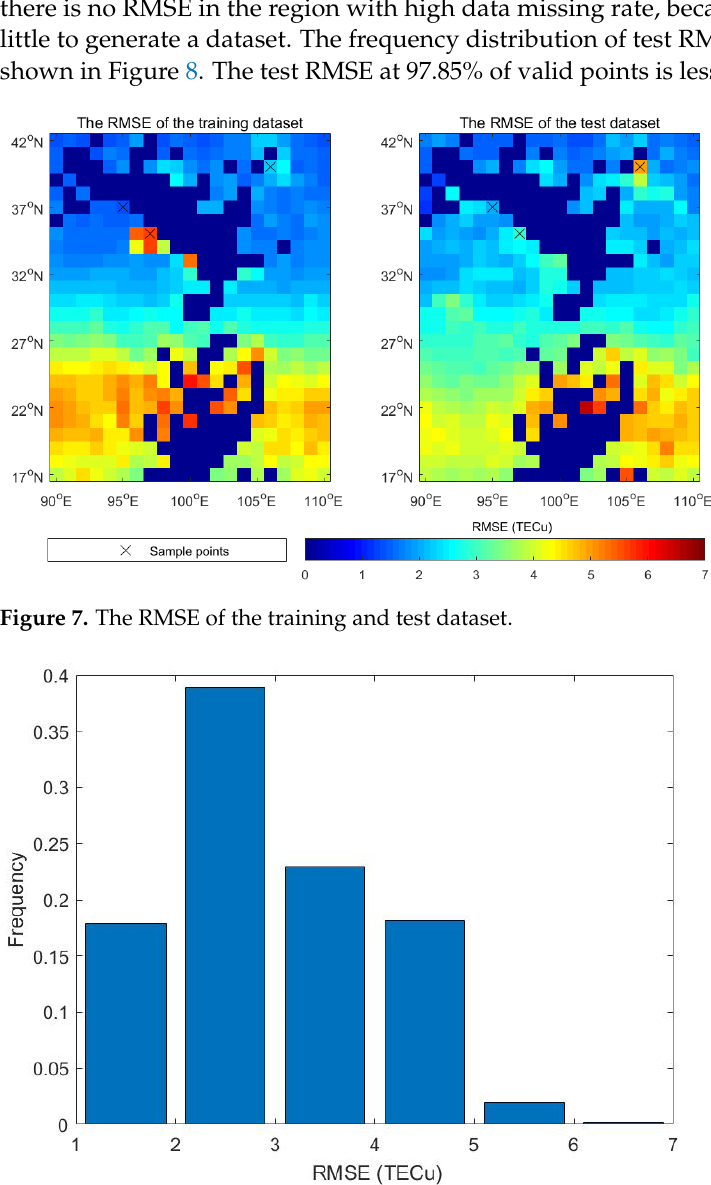
Figure 8. The frequency distribution of test